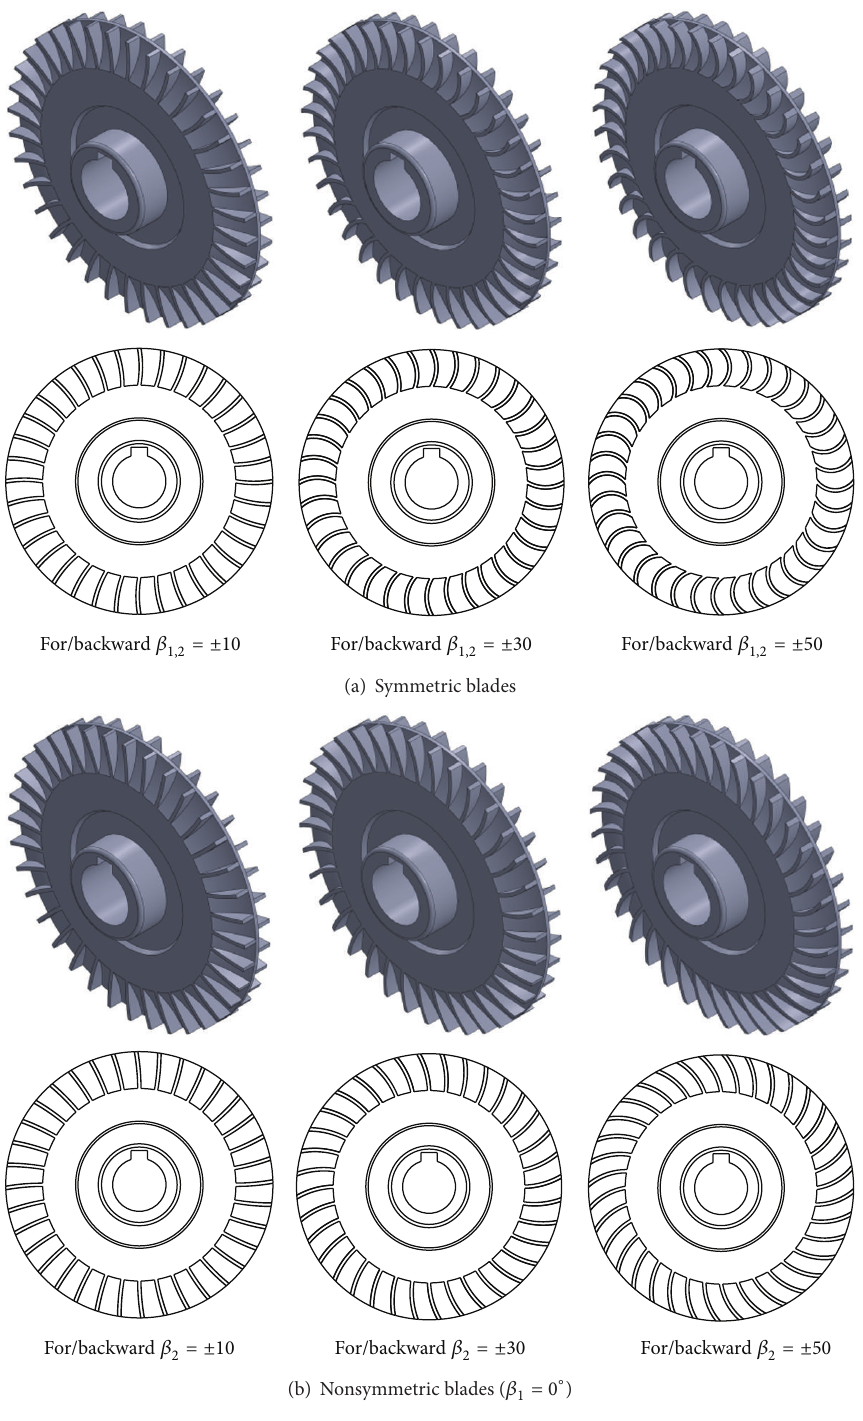
Figure 15: Geometry of impellers: (a) symmetric blades and (b) nonsymmetric